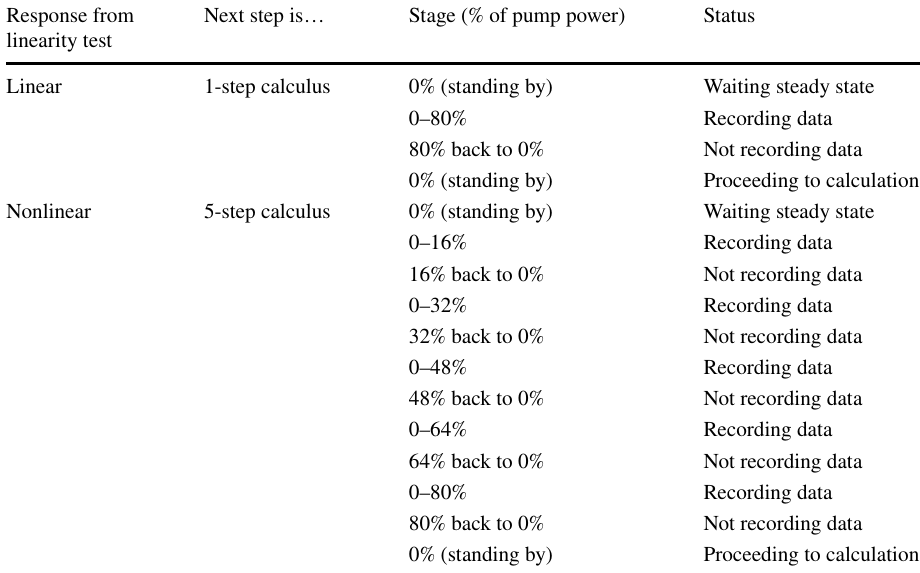
Table 2 Procedure adopted after the linearity is determined based on SK technique in open